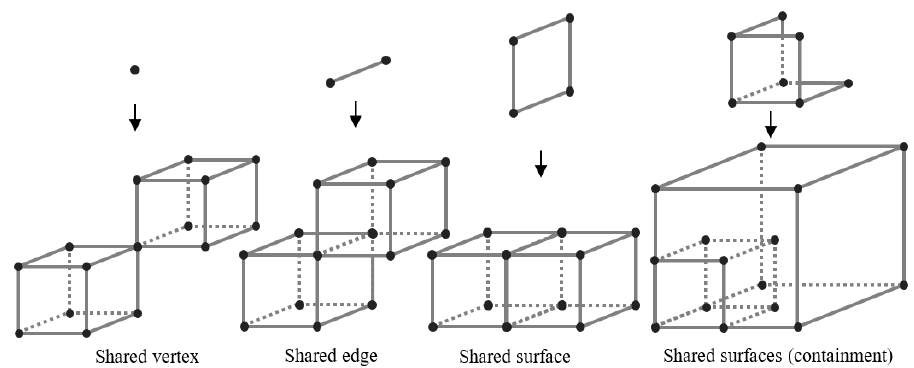
Figure 6. Diverse relationships between shared geometry.